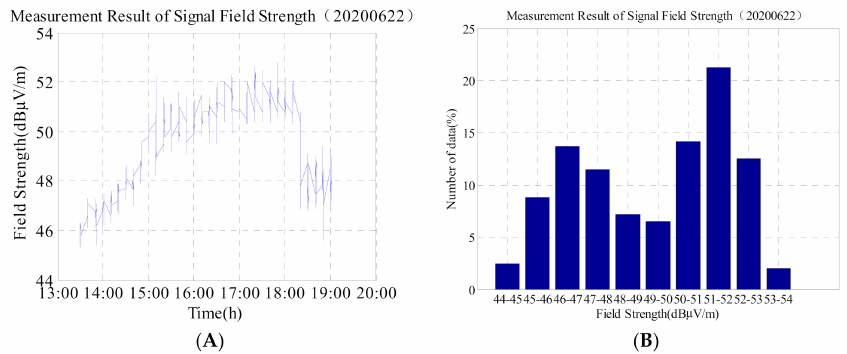
Figure 8. ( A ) Field strength change of the low-frequency time-code signal on 22 June 2020; and ( B ) corresponding histogram. Total number of data is 1104.